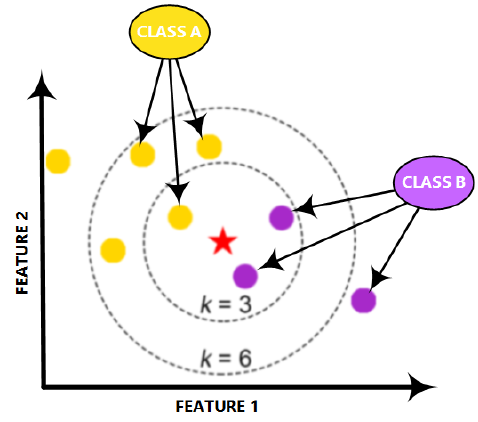
Figure 6. Structure of the KNN